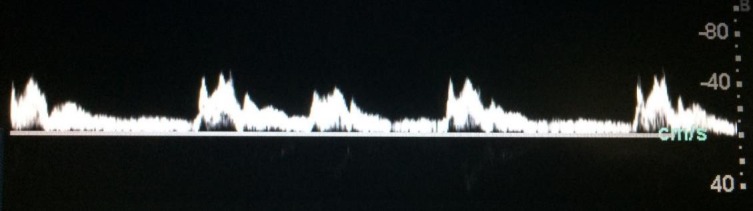
Pulsus bisferiens and extrasystole.